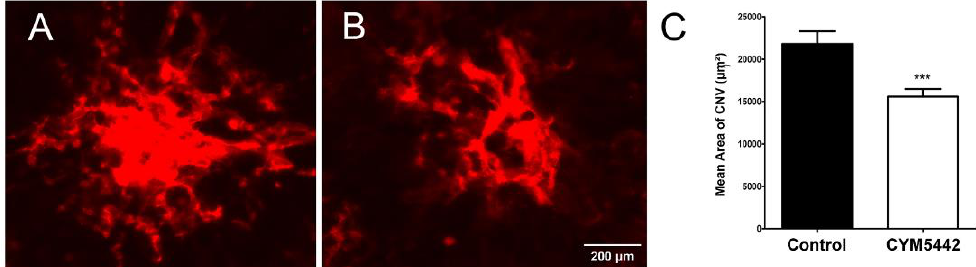
Figure 10. A single intravitreal injection of the S1PR1 agonist CYM5442 inhibits CNV in a mouse model of nAMD. C57BL/6j male and female mice, 2 months old, received a single intravitreal injec- tion of ( A ) vehicle control or ( B ) CYM5442, 1 μL of a 10 µM stock, following the laser rupture of Bruch’s membrane as described in Methods. After 14 days, the eyes were processed for staining with anti-ICAM-2 antibodies and quantification of new choroidal blood vessels ( C ). *** p < 0.001. ( n = 10 mice per